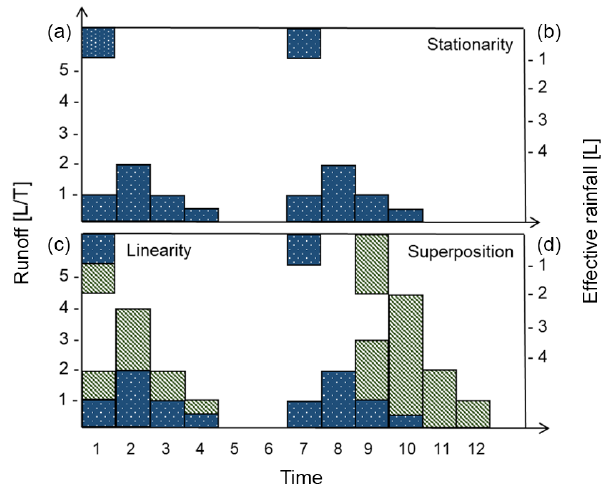
Figure 1. An example of a UH (a) and an illustration of the princi- ples of stationarity (b) , linearity (c) , and superposition (d) . Units for runoff are provided as catchment area specific runoff in length (L) per time (T).